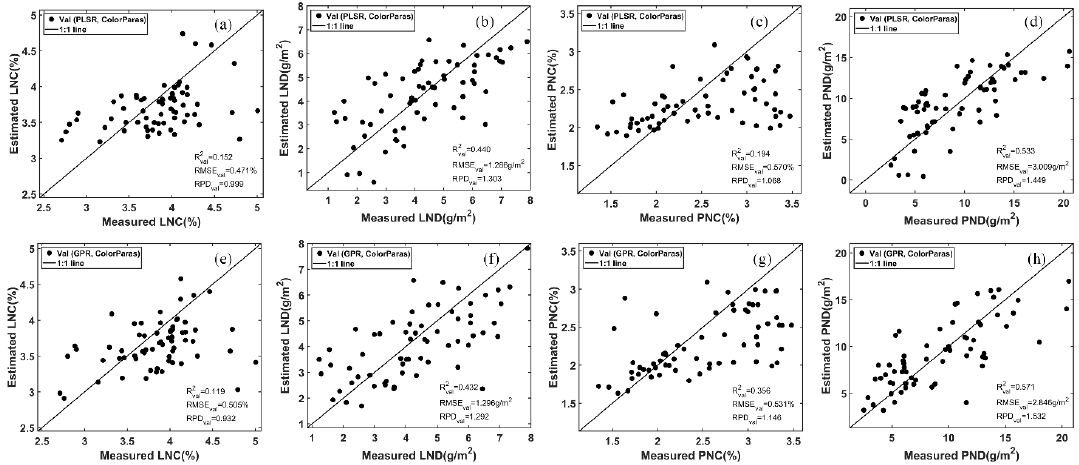
Figure 6. The predictive performance of ( a – d ) the PLSR and ( e – h ) GPR models based on the combination of color parameters for winter wheat N status estimation.